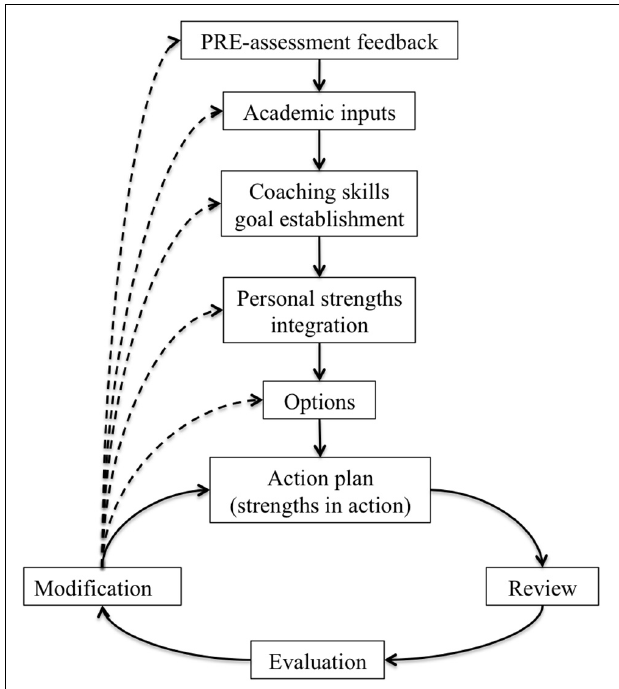
FIGURE 2 | Coaching-based leadership intervention program